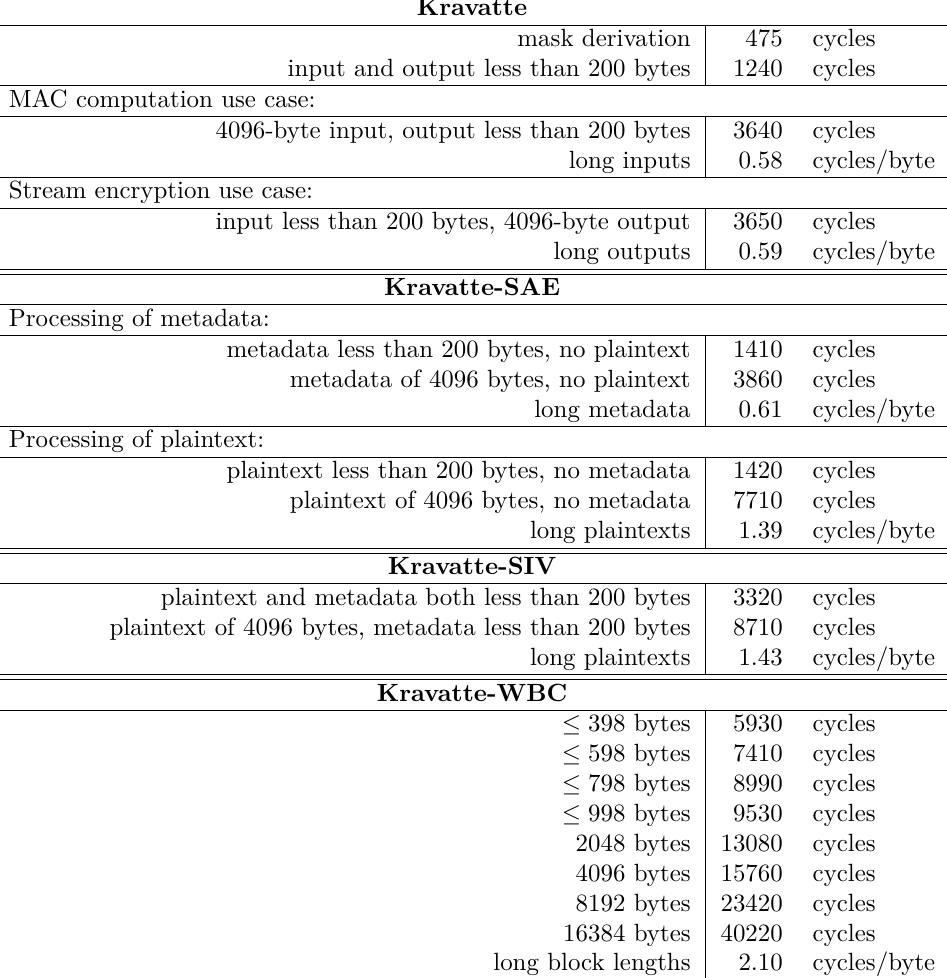
Table 1: Performance measured on Skylake (single core).